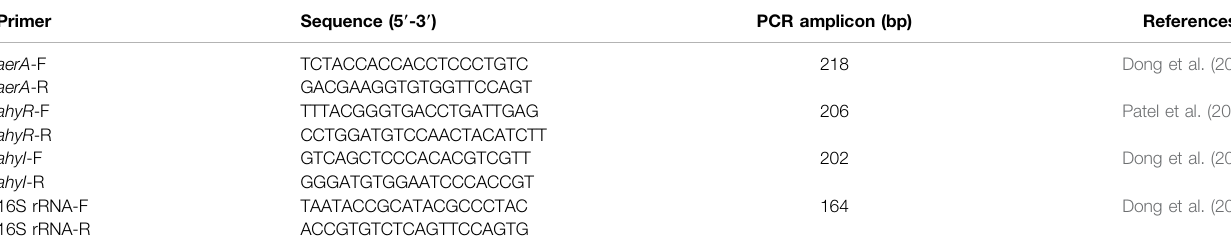
TABLE 1 | Primer pairs used in qPCR